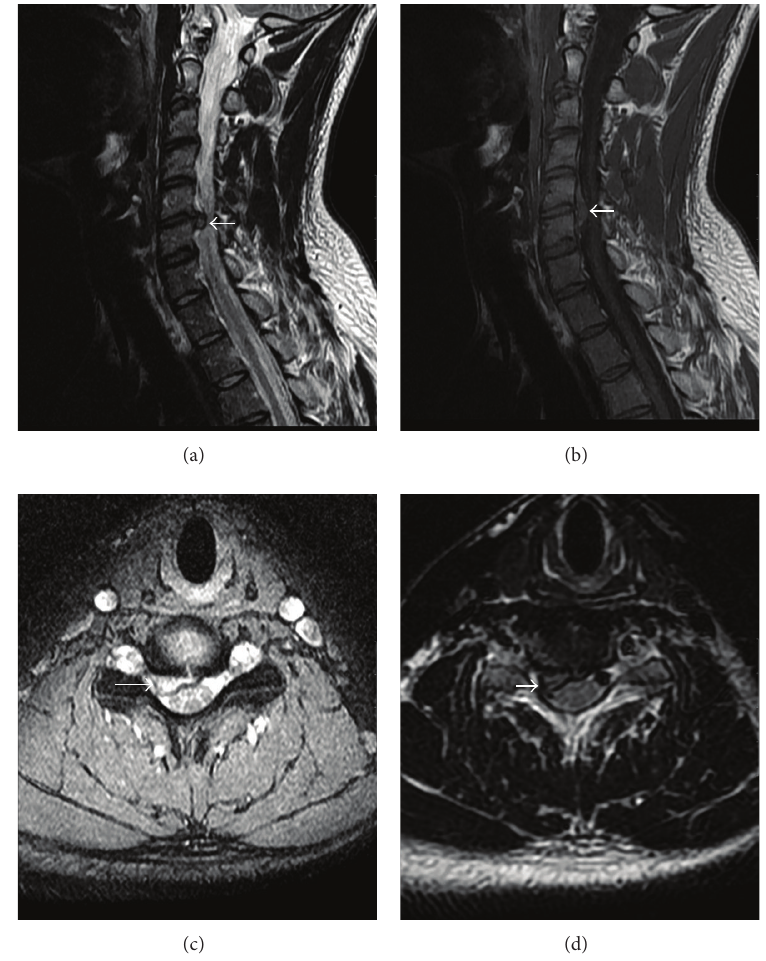
Figure 1: Sagittal T2-weighted (a), sagittal T1-weighted (b), axial T2 ∗ (c), and axial T2-weighted (d) MRI images show a large cranially and caudally migrating posterior disc extrusion (herniation) at C5-C6 level (arrows), eccentric to the right side and impinging upon the subarachnoid space, the cervical cord, and the right C6 nerve